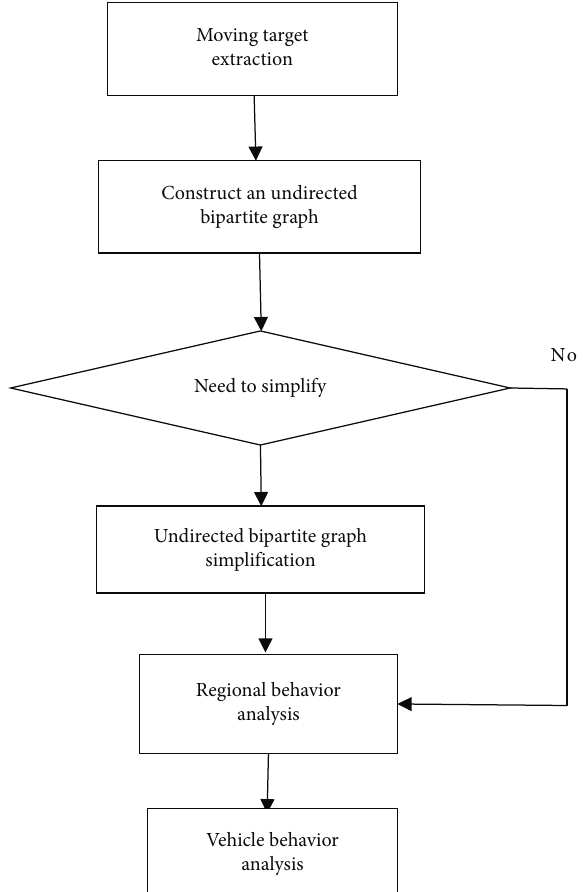
Figure 1: Flowchart of vehicle behavior